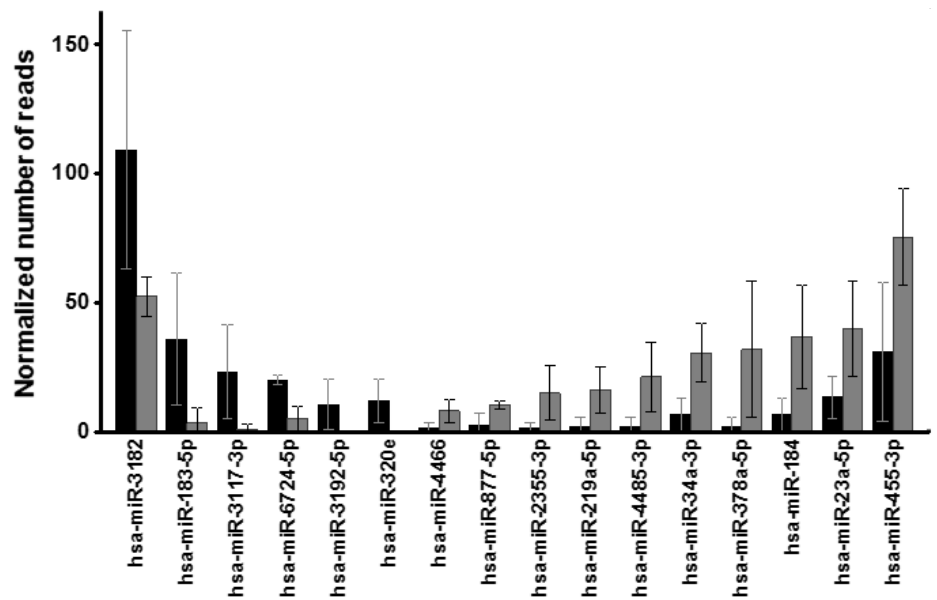
Figure 6. miRNAs whose relative abundance levels in exosomes produced by stromal cells from healthy corneas and from KC show statistically significant differences (Mann-Whitney U test). The normalized number of reads values for healthy corneas (black bars) and KC (gray bars) are shown. The spreads represent the standard deviation.